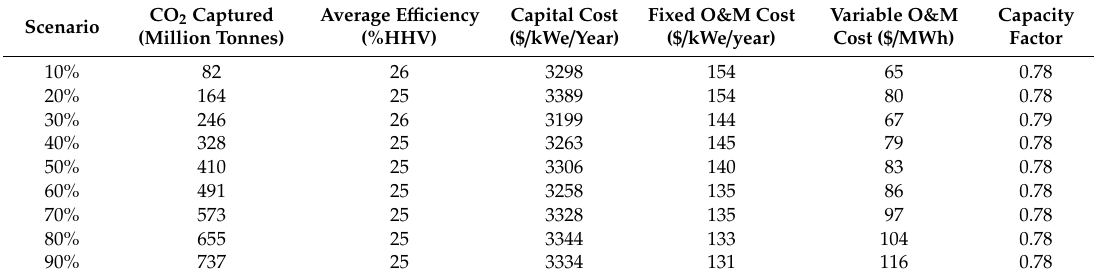
Table 6. Average e ffi ciency (%HHV), capital cost ($ / kWe), fixed O&M cost ($ / kWe / year), variable O&M cost ($ / MWh), and capacity factor for the IGCC 2040 advanced (pelletized) logistics scenario.